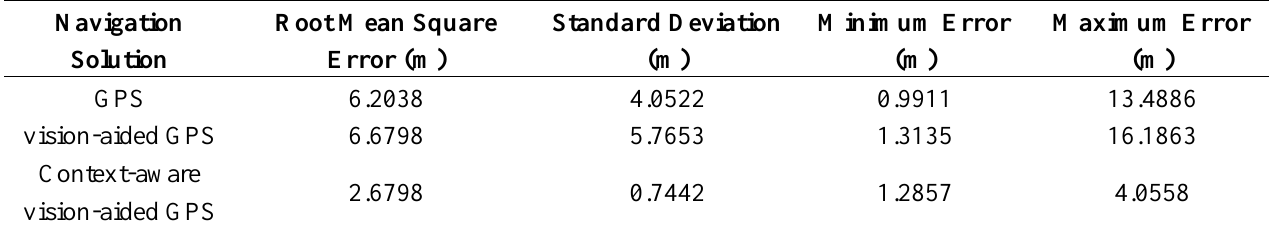
Table 8. Improvement in context-aware vision-aided GPS navigation in compare with GPS navigation.